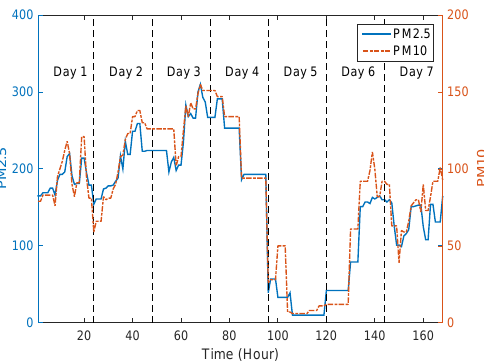
Figure 13. Variation tendency of PM2.5 and PM10 in monitoring station S 9 during the time period of 21–27 April